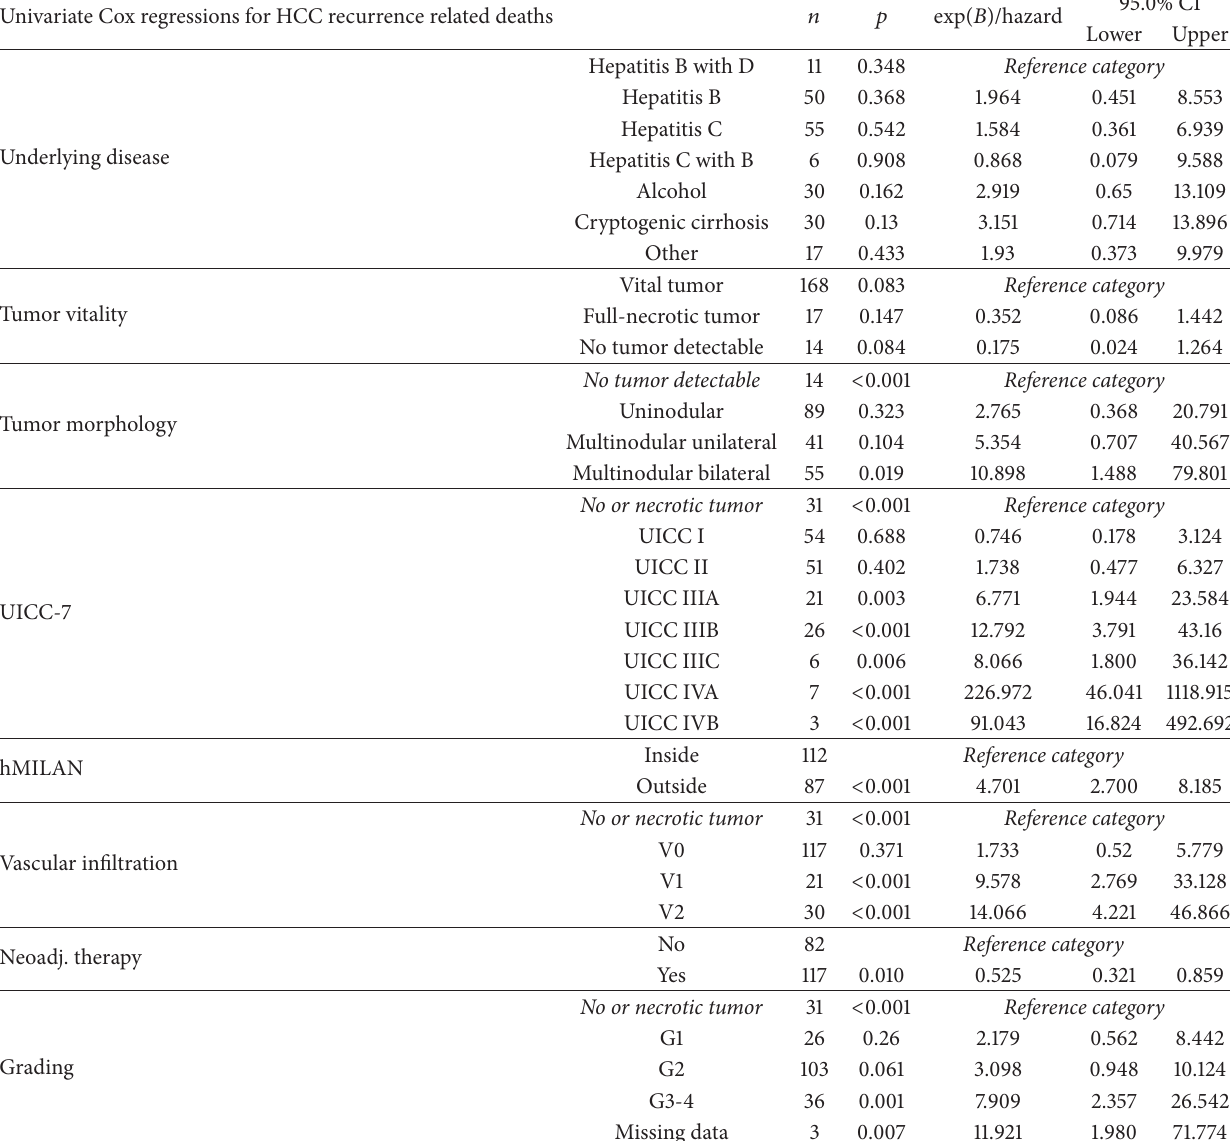
Table 6: Identification of hazards for HCC recurrence related deaths by univariate Cox regression, 𝑛 = 199 (non-HCC recurrence related deaths